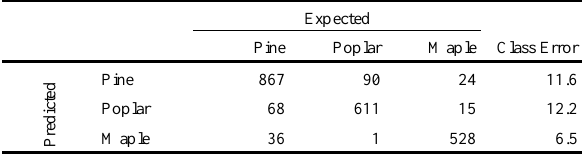
Table 3. Confusion matrix for the classification accuracy averaged over 20 iterations using 30% of the data for training using geometric derived features (values are average over 20 iterations)